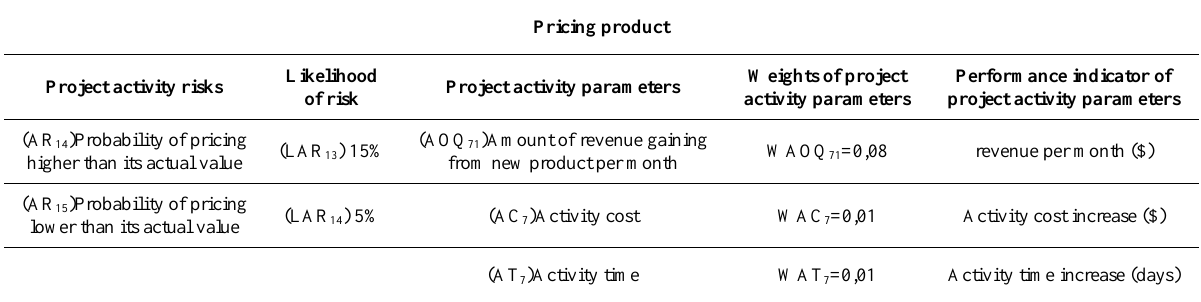
Table 8.TOPSIS table information of pricing product.